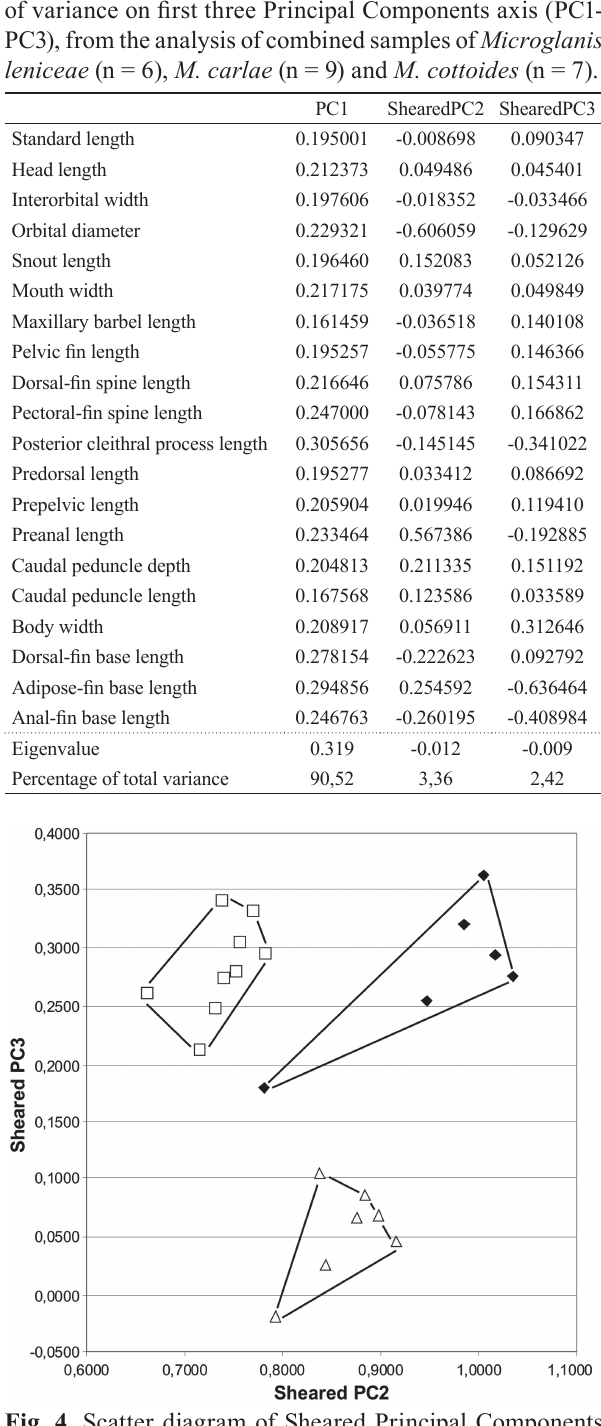
Fig. 4. Scatter diagram of Sheared Principal Components analysis of combined samples of Microglanis leniceae (diamond, n = 6), M. carlae (squares, n = 9), and M. cottoides (triangle, n =